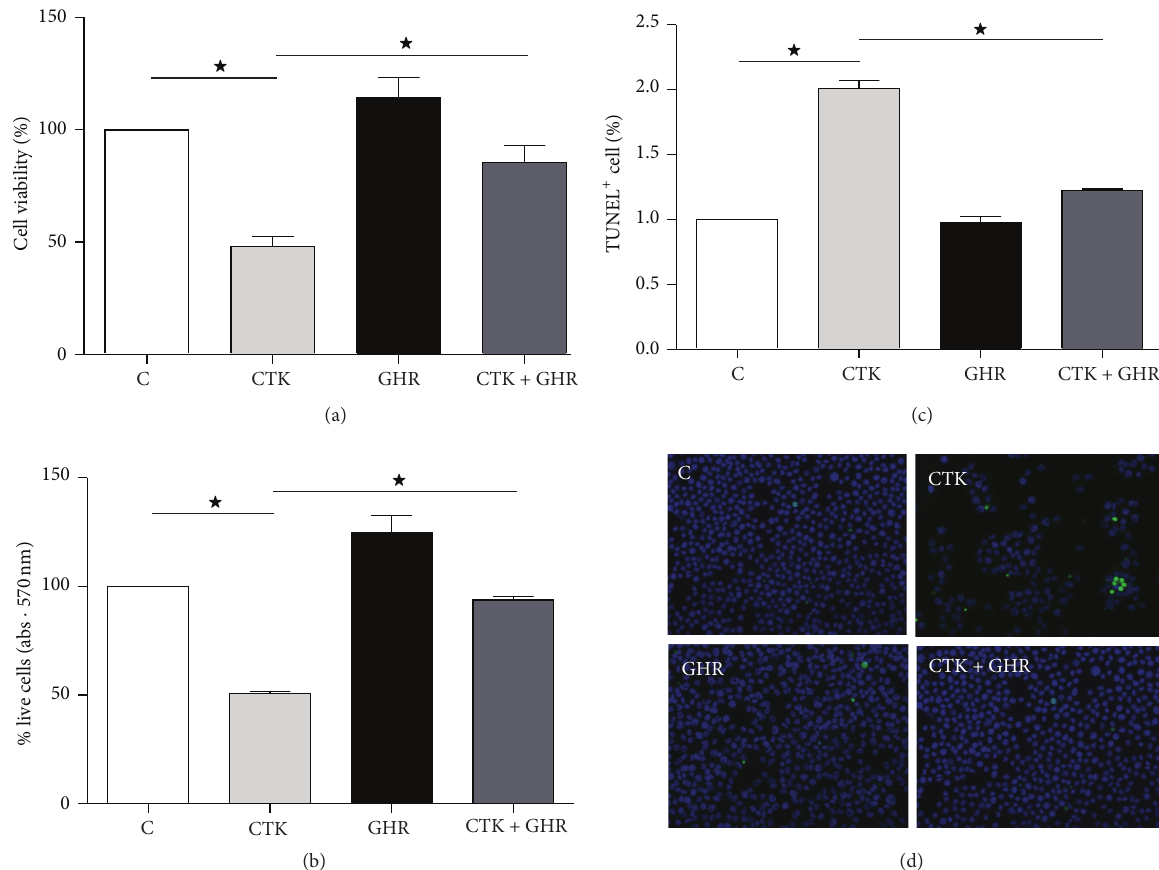
Figure 1: Ghrelin and cytokines’ effects on cell survival and its survival pathways. Trypan blue exclusion test of cell viability (a), MTT assay for cell viability (b), and TUNEL-positive cells quantification to determine ghrelin’s effects on apoptosis-mediated cellular death (c). Cells were incubated for 48 h in the absence or presence of cytokines, ghrelin, or both. (d) shows representative photomicrographs of control, cytokines (CTK), ghrelin (GHR), and cytokines + ghrelin (CTK + GHR), ∗ 𝑝 < 0.05 between